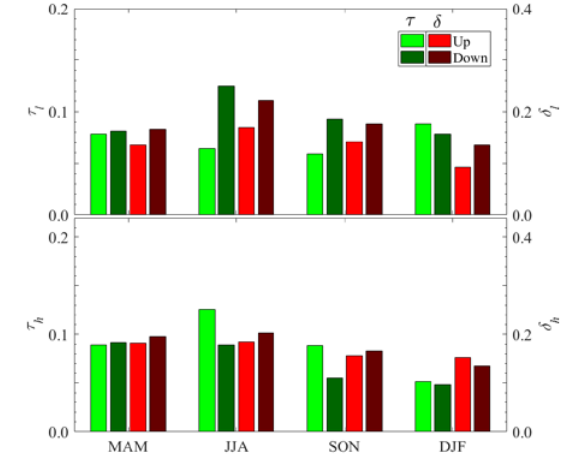
Figure 5 Seasonal variations of AOD and PDR over Up and Down segments, CALIPSO recordings, Jun. 2007 to Dec. 2017, a) and b) l and h altitude regimes.